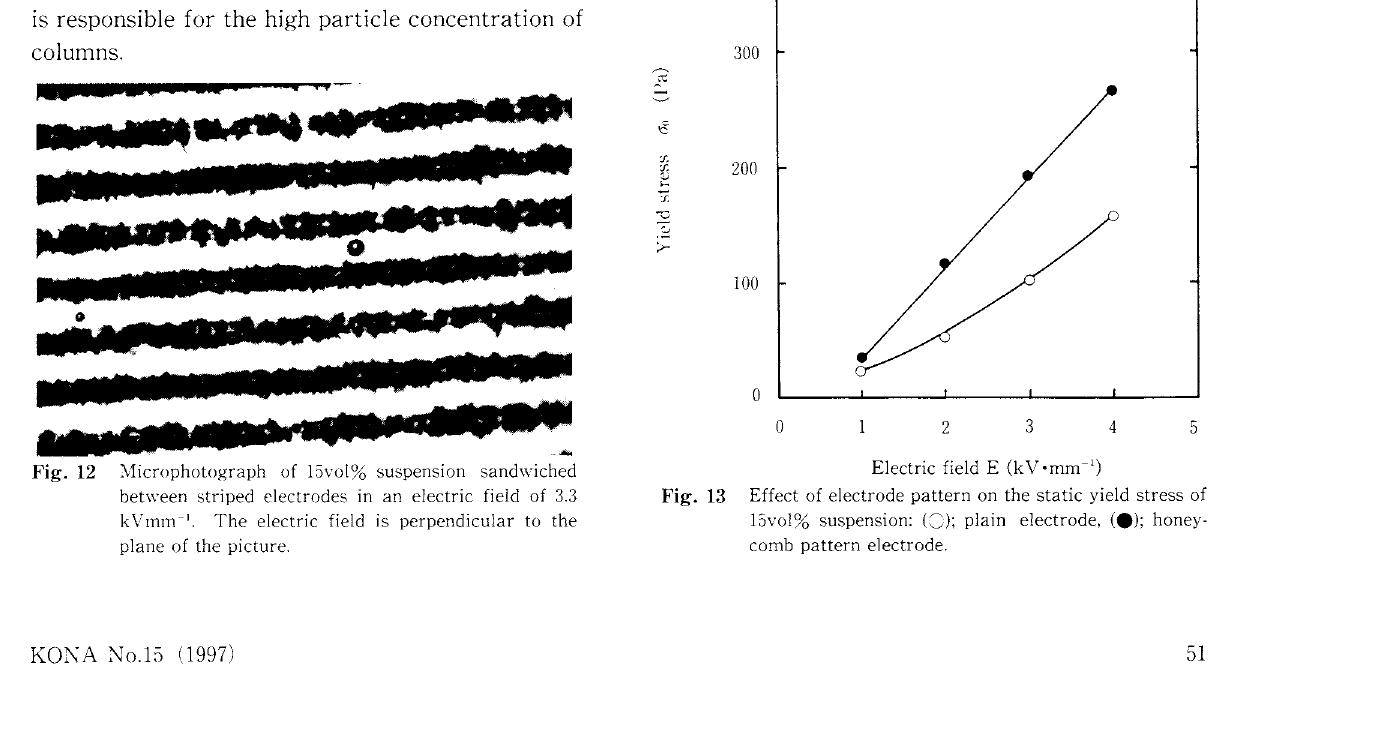
Fig. 12 :\Iicrophotograph of !Svol% suspension sandwiched between striped electrodes in an electric field of 3.3 k\'mm .,_ The electric field is perpendicular to the plane of the picture.